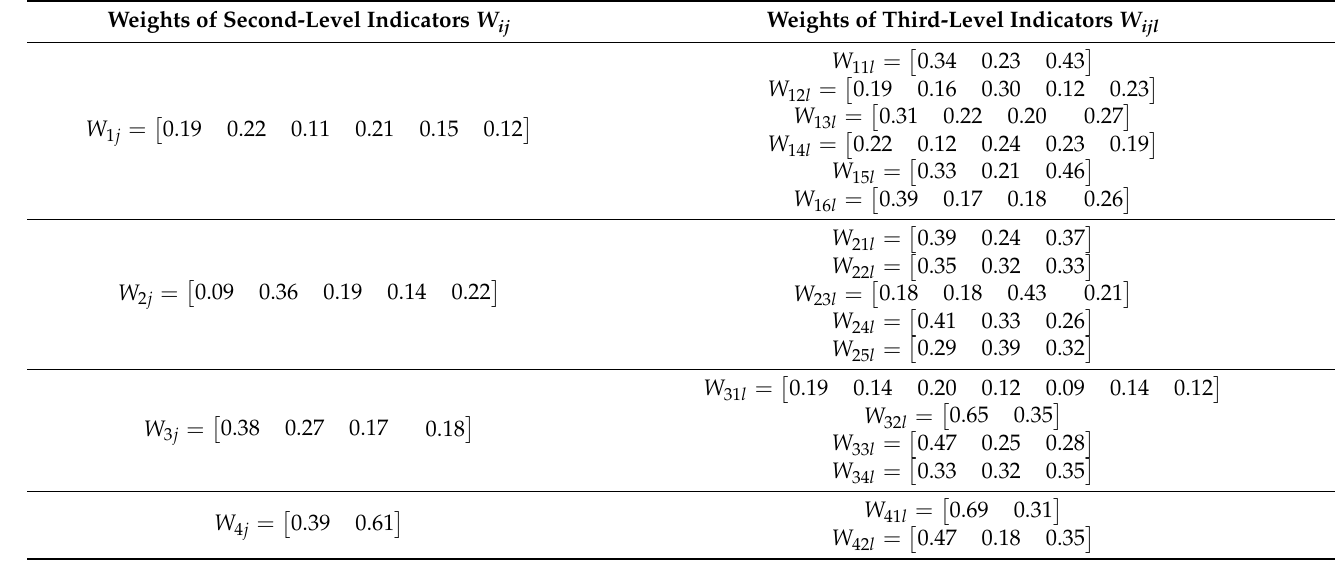
Table A11. Weights of competency assessment indicators of the full-time emergency rescue